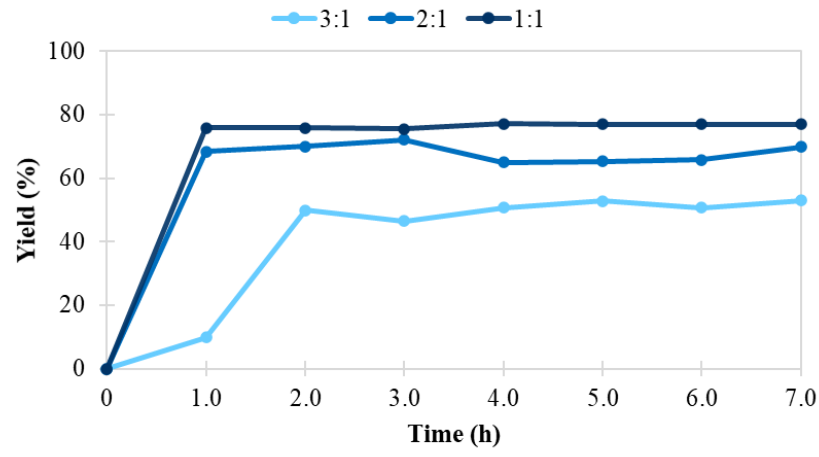
Figure 11. Ester yield (%) in the continuous enzymatic synthesis of n -amyl caproate in a solventless system, catalyzed by sol-gel-entrapped Candida antarctica B lipase at a flow rate of 0.2 mL/min, a temperature of 80 °C, and different substrate molar ratios.